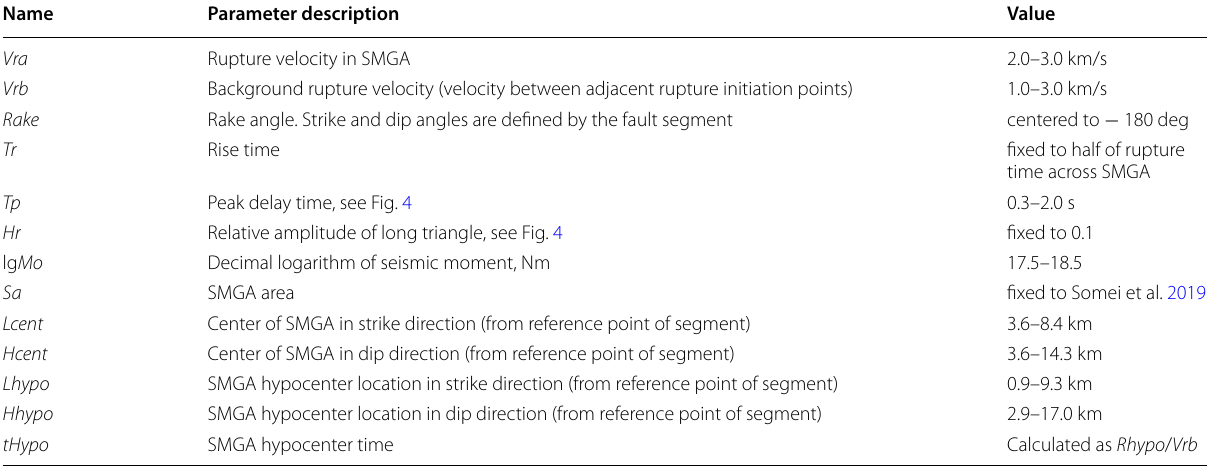
Table 2 List of search parameters in this study. Value ranges are used in inversion